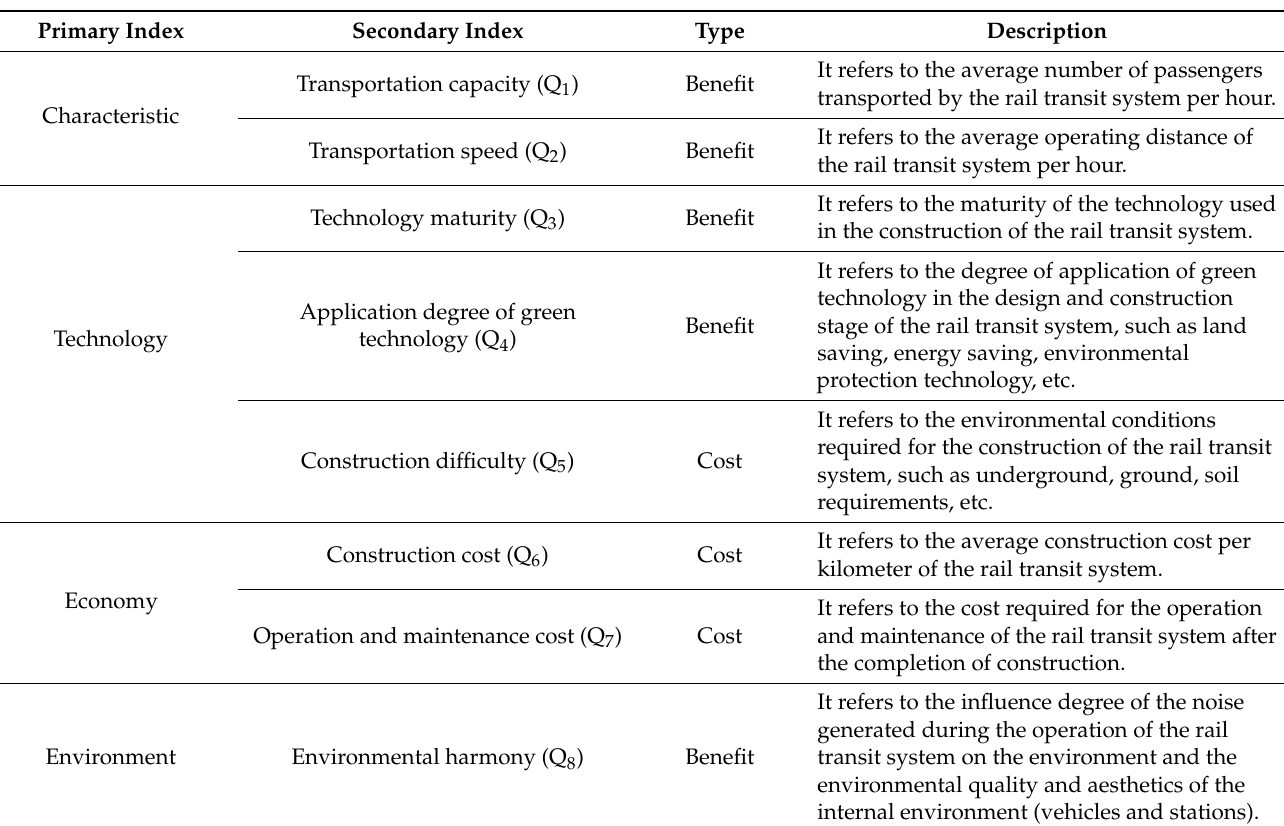
Table 3. The evaluation criteria of urban rail transit